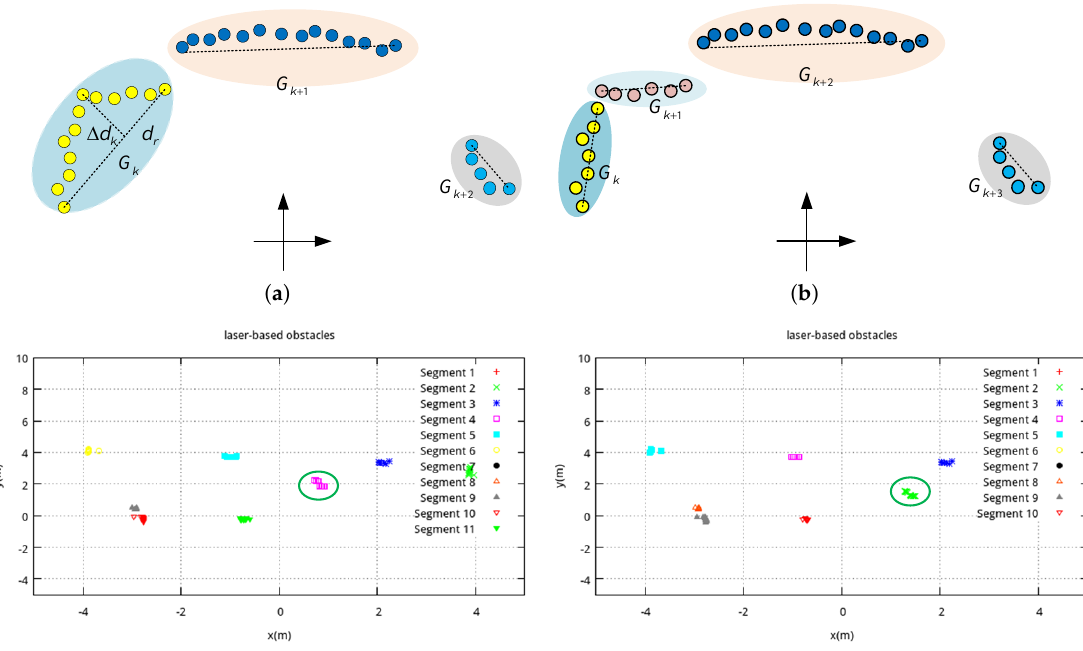
Figure 5. Comparison of the laser groups before and after splitting and a real example. ( a ) before splitting; ( b ) after splitting; ( c ) clustering